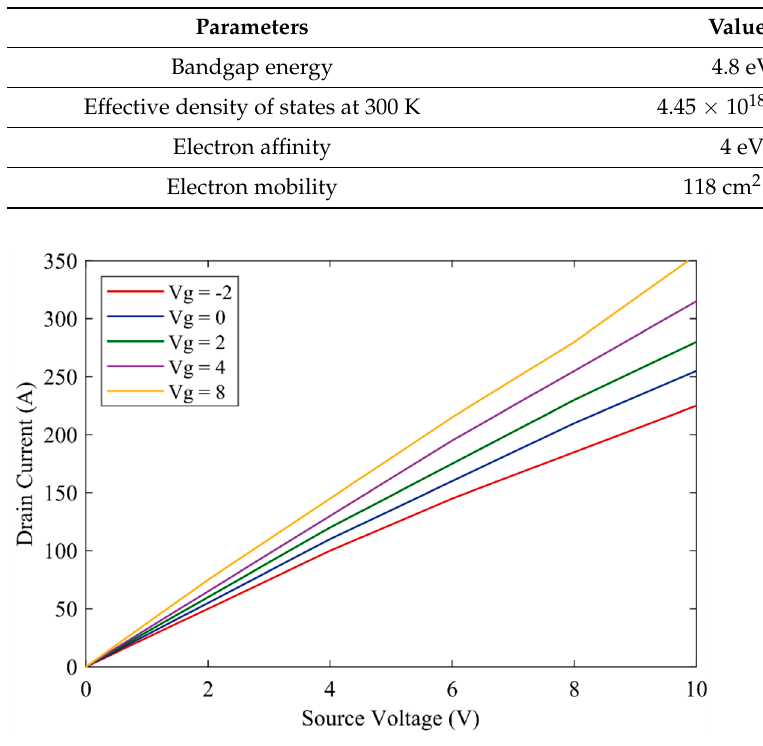
Figure 2. I-V characteristics of Ga 2 O 3 semiconductor switches. Table 1. Parameters used in TCAD for analyzing conduction behavior of Ga 2 O 3 switches.